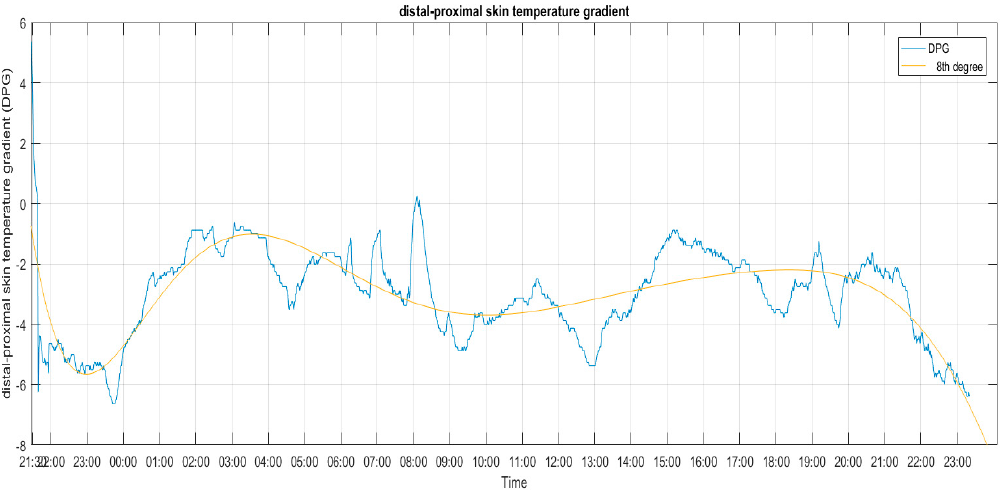
Figure 5. Distal-proximal skin temperature gradient (DPG) over a 24 h period.